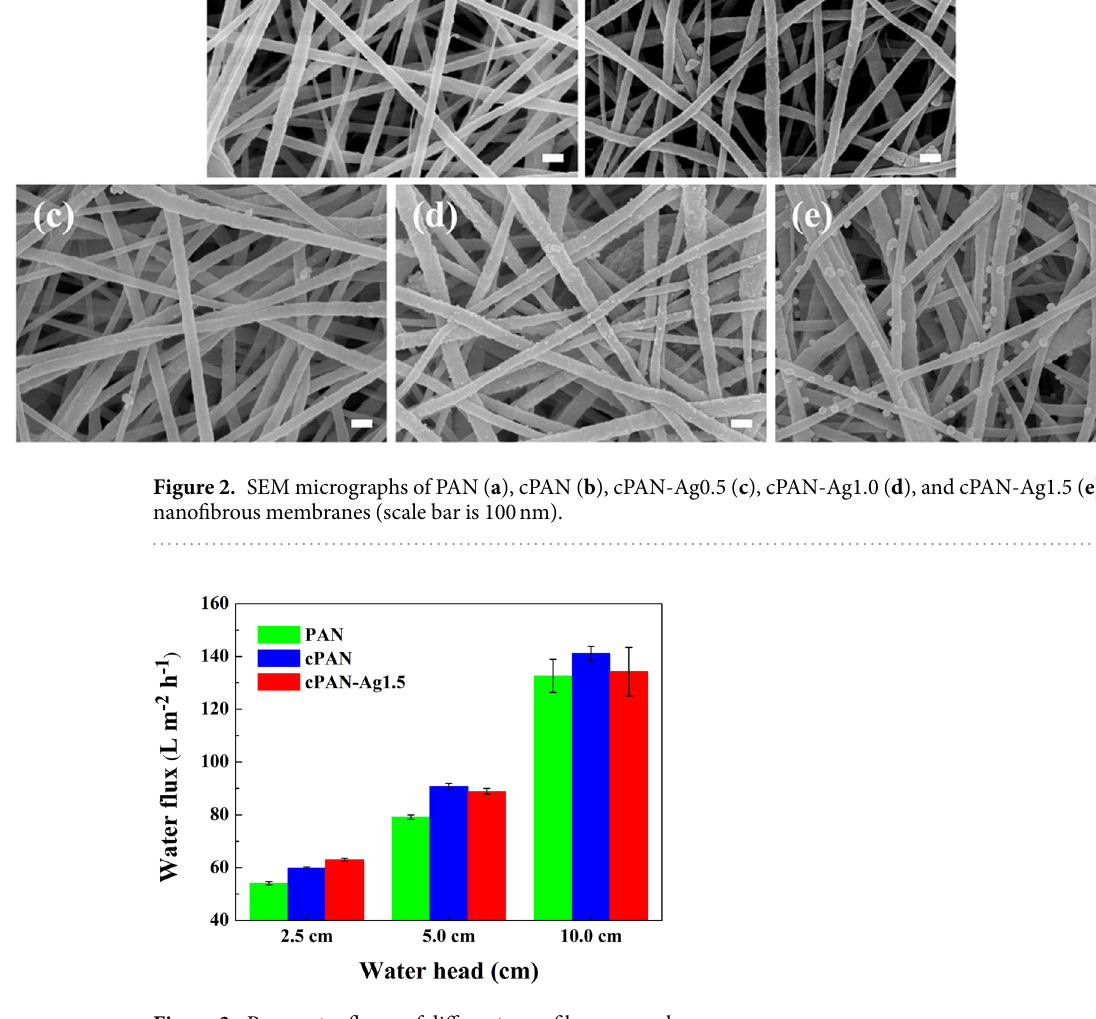
Figure 3. Pure water fluxes of different nanofibrous